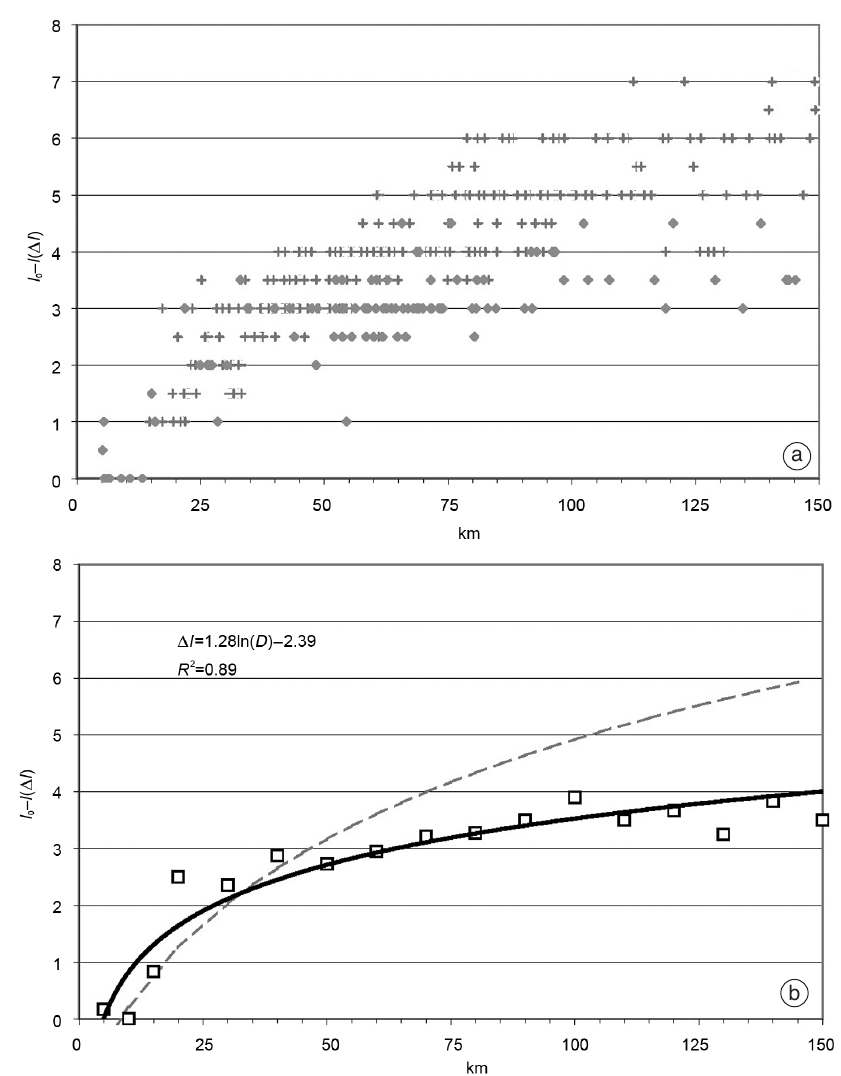
Fig. 10a,b. Aeolian Islands. a) Hypocentral distances versus ∆ I for the earthquakes used in the analysis (diamonds) and comparison with the 1978 Gulf of Patti earthquake intensity data (crosses). b) Best fits (solid line) of the logarith- mic relationship for the arithmetic average of ∆ I (squares) and comparison with the Peruzza (2000) equation